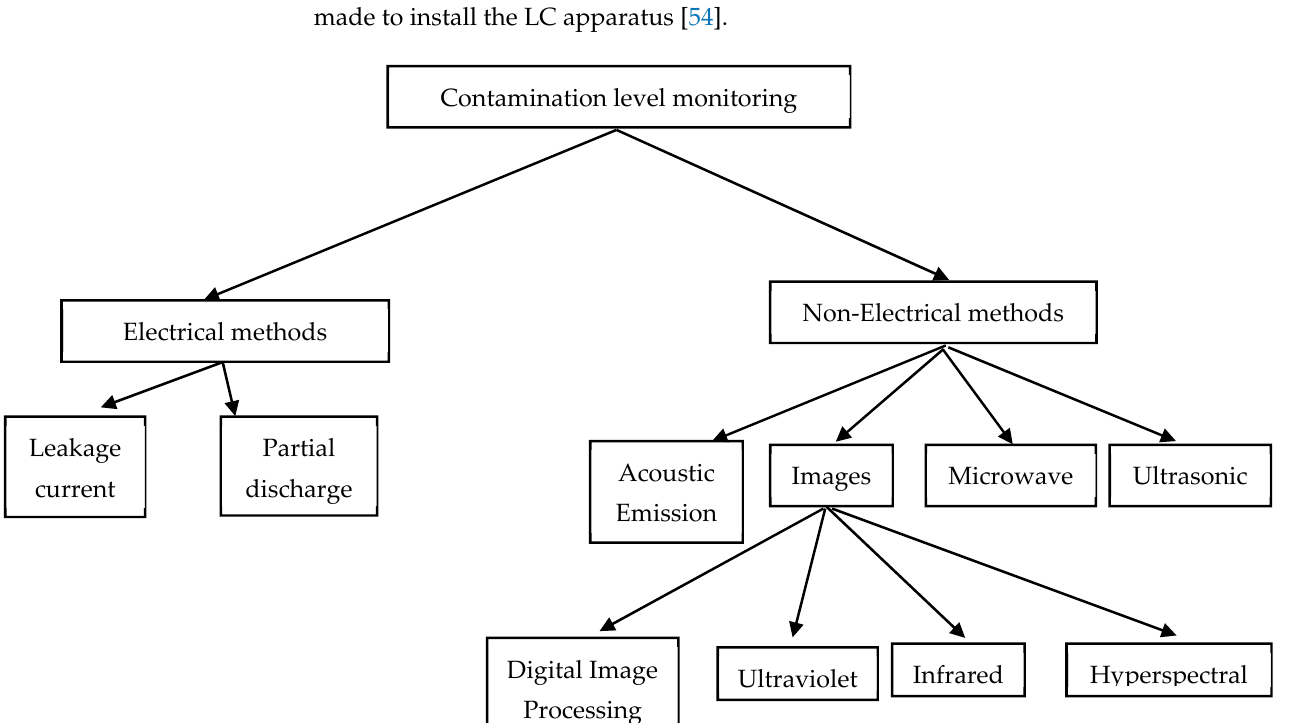
Figure 2. Different contamination level monitoring methods.